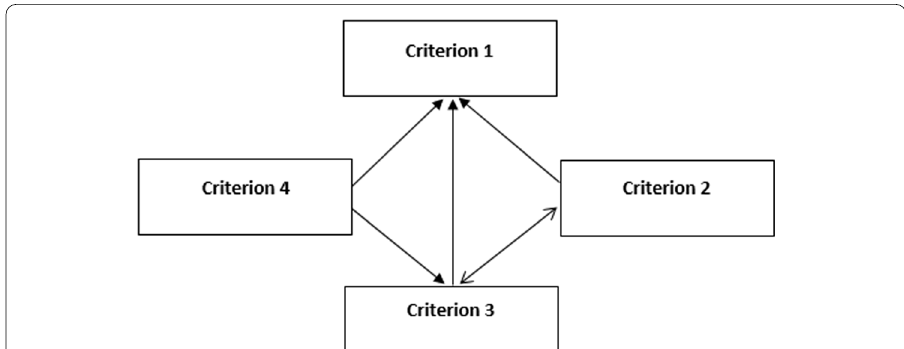
Fig. 4 Impact-relation directions of consensus-based multidimensional due diligence for peer-to-business debt model